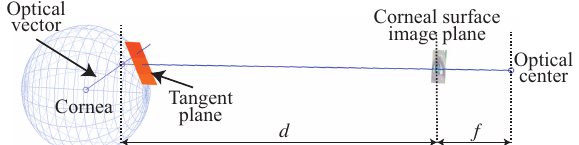
Figure 5 . Relationship between the cornea, tangent plane, optical axis, and input